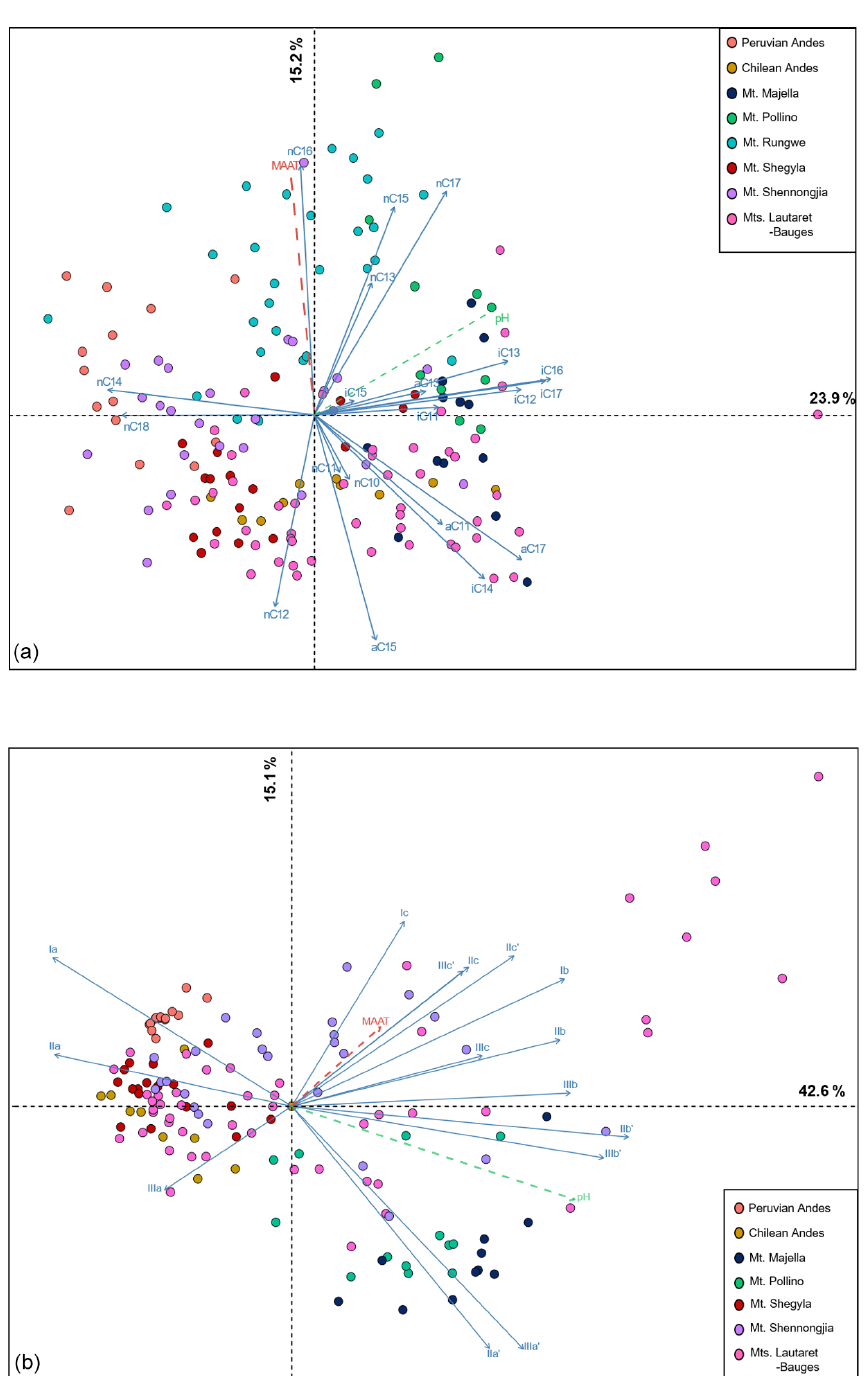
Figure 3. PCA biplot of (a) 3-OH FA fractional abundances in soil samples from the eight altitudinal transects and (b) brGDGT fractional abundances in soil samples from seven of the eight altitudinal transects. The brGDGT data from Mt. Rungwe, for which 5- and 6-methyl isomers were not separated, were not included in the